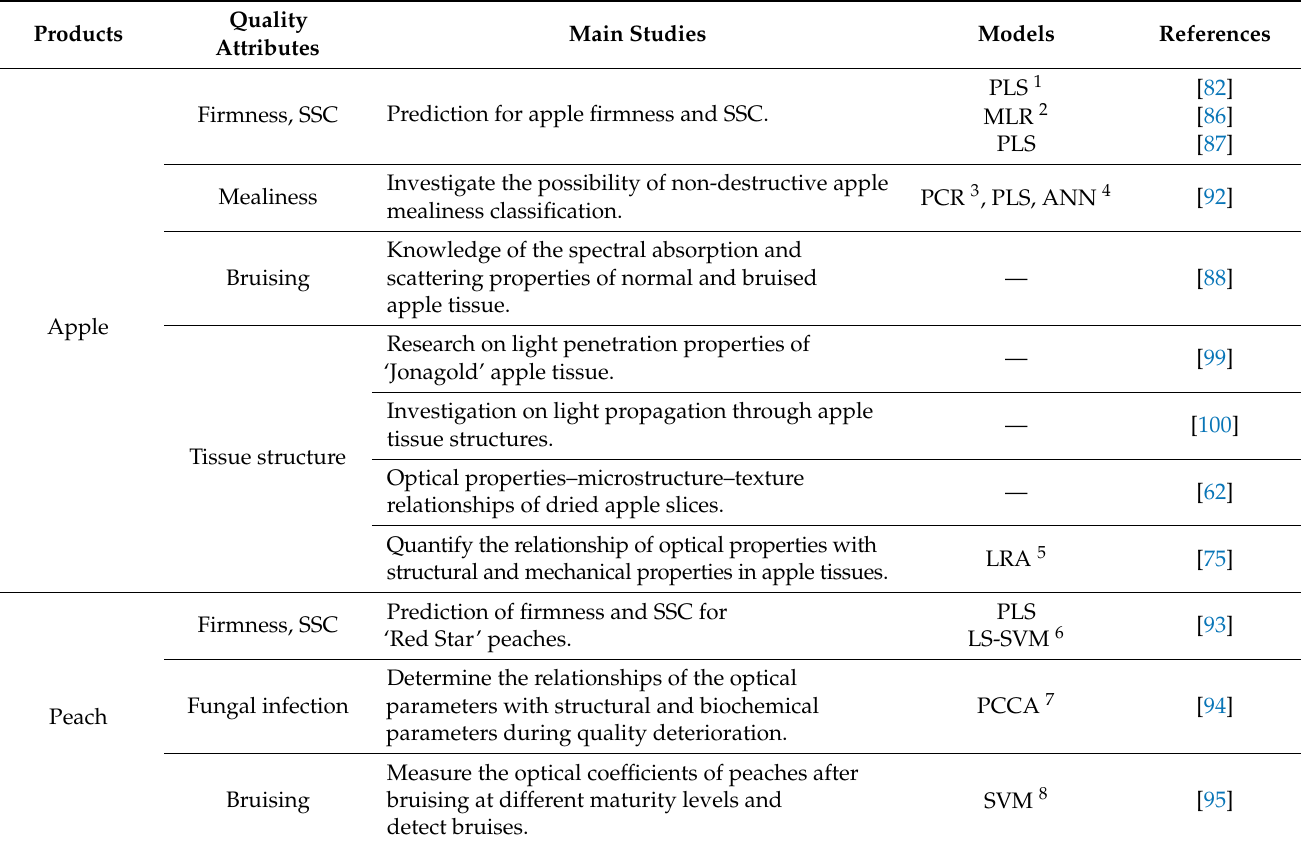
Table 2. Post-harvest quality assessment by optical properties of fruits and